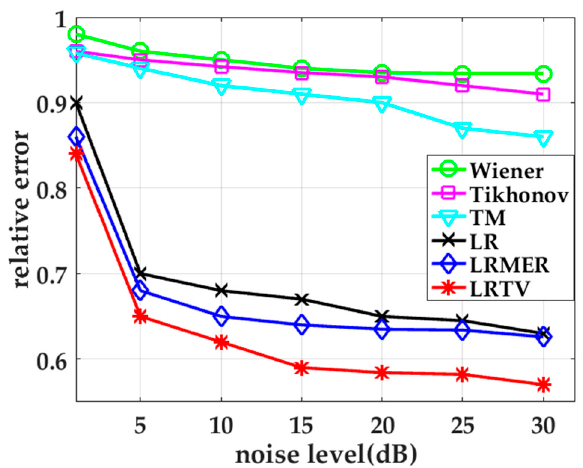
Figure 7 . Relative error (RE) curve comparison under different noise levels. Figure 7. Relative error (RE) curve comparison under different noise levels.